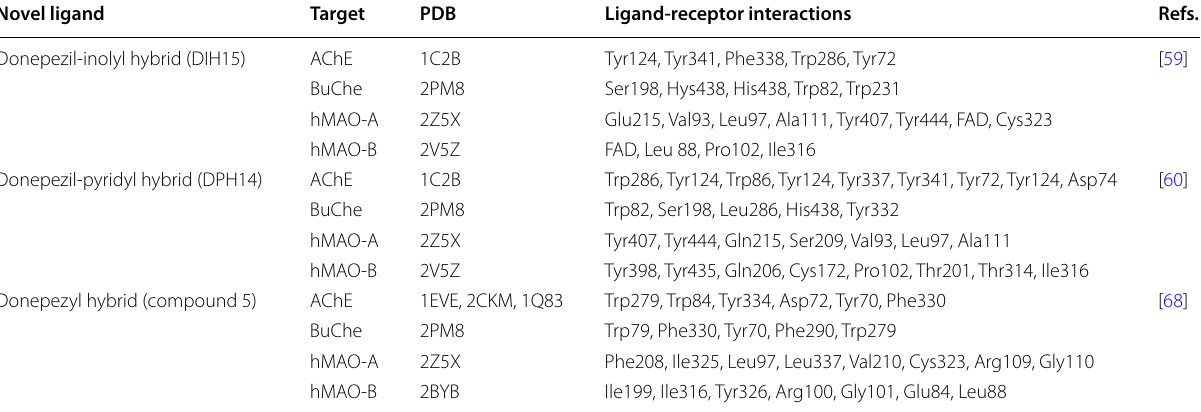
Table 1 The examples of successful docking studies used in ligand discovery for the treatment of AD Novel